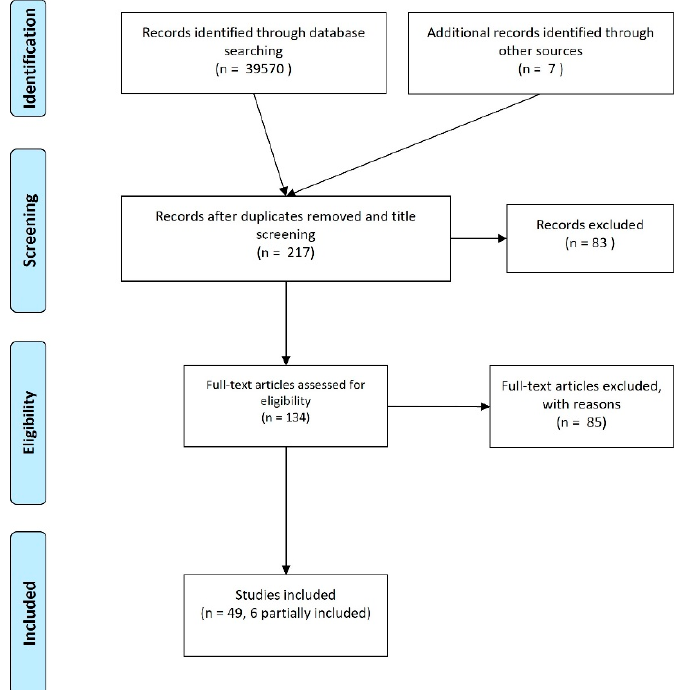
Figure 1. Flowchart of the manuscript retrieval process.